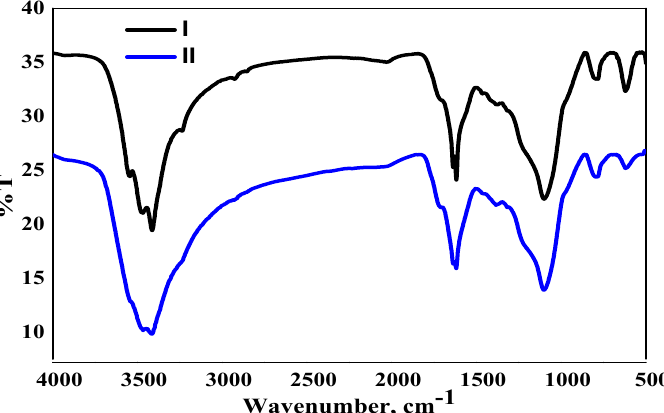
Figure 1. Fourier transform infrared spectroscopy (FTIR) of (I) rice husk char (RHC4) and (II) Cu(II)-loaded RHC4 (adsorbent dose: 8 g / L, Cu(II) concentration: 80 mg / L, contact time: 120 min). Cu(II)-loaded RHC4 (adsorbent dose: 8 g/L, Cu(II) concentration: 80 mg/L, contact time: 120 min). Field-emission scanning electron microscopy (FESEM) images of RHC4 and Cu(II)-loaded